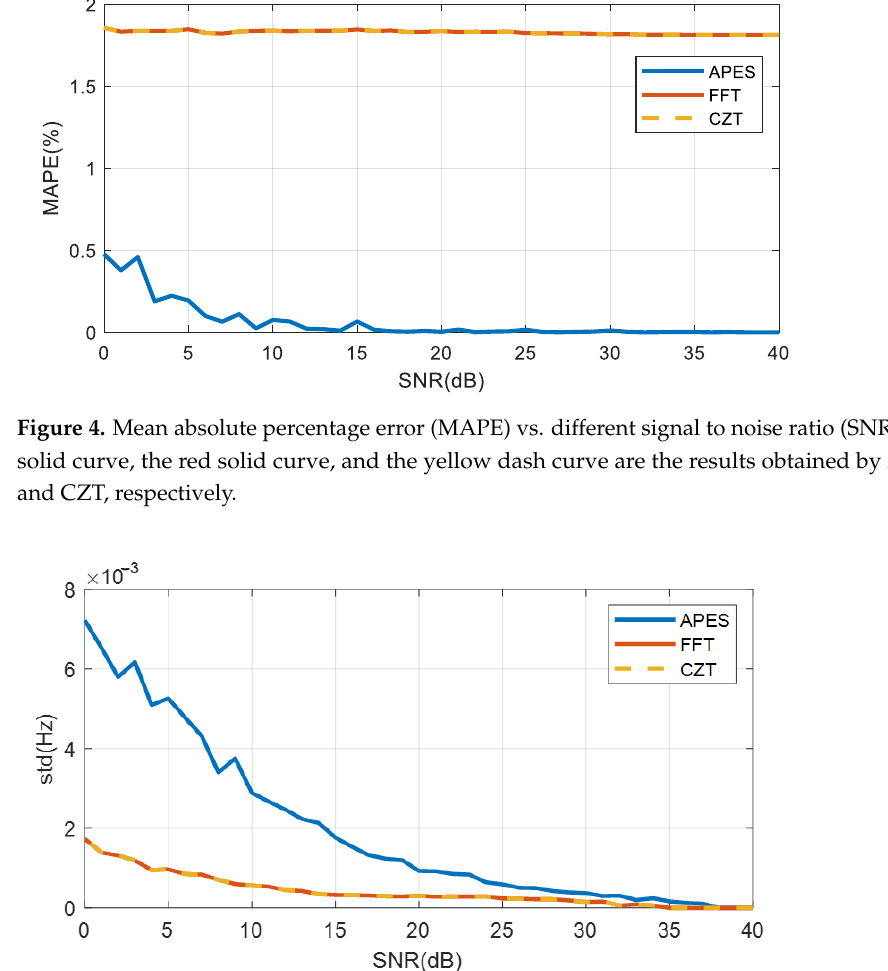
Figure 5. Standard deviation of frequency estimation error vs. different SNR. The blue solid curve, the red solid curve, and the yellow dash curve are the results obtained by APES, FFT, and CZT, respectively.